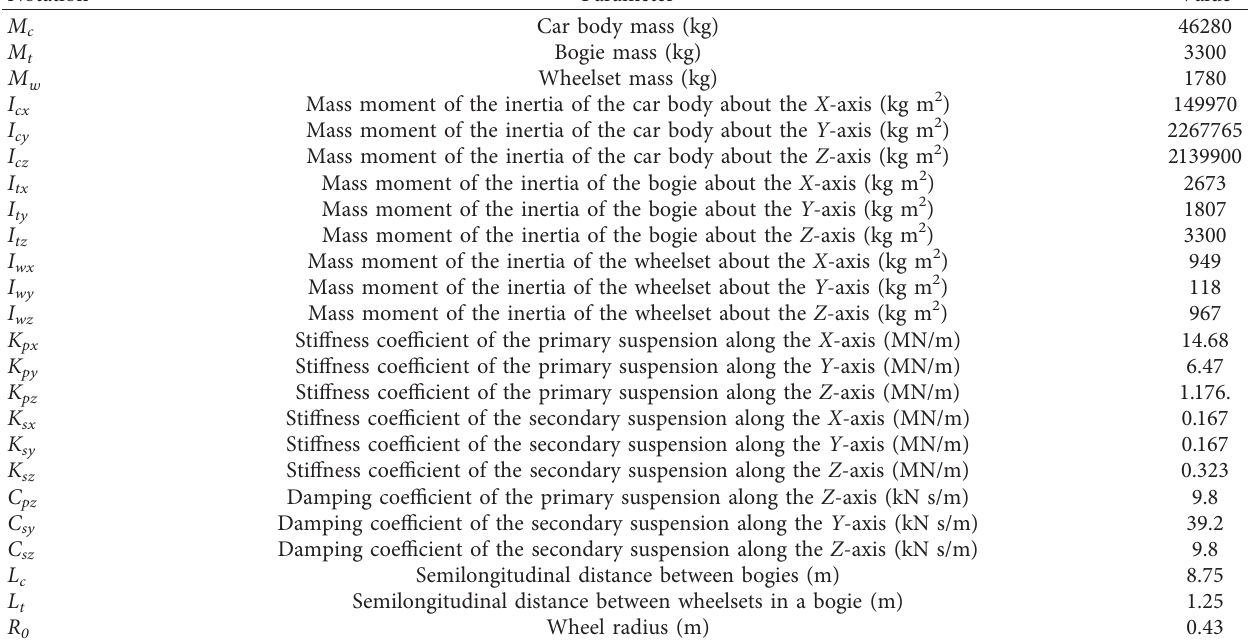
Table 1: Main parameters of the railway vehicles used in the